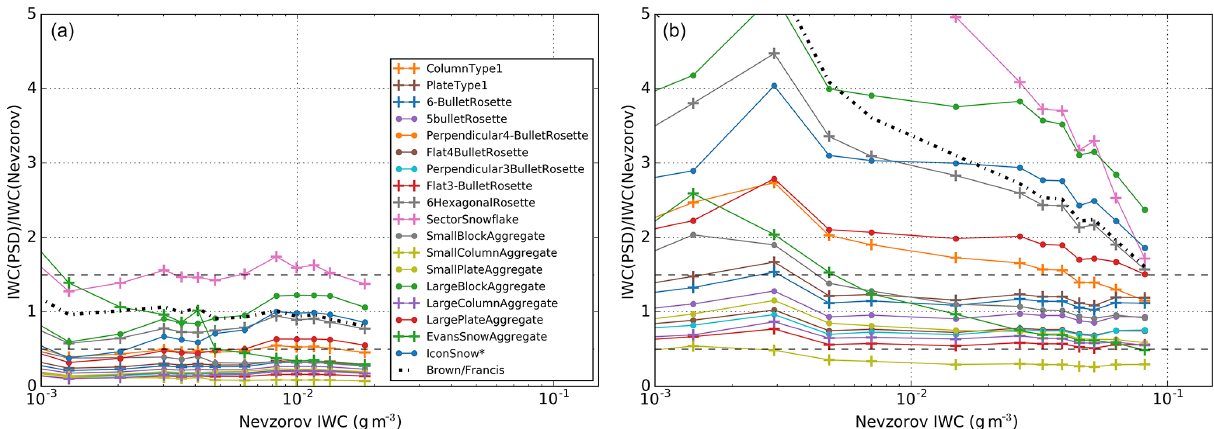
Figure 5. Ratio of IWC derived from the in situ PSDs for each particle habit with bulk IWC measured using the Nevzorov probe for B895 (a) and B939 (b) . The dashed–dotted line uses the Brown and Francis (1995) m – D relationship and the dashed horizontal lines indicate ± 50%.